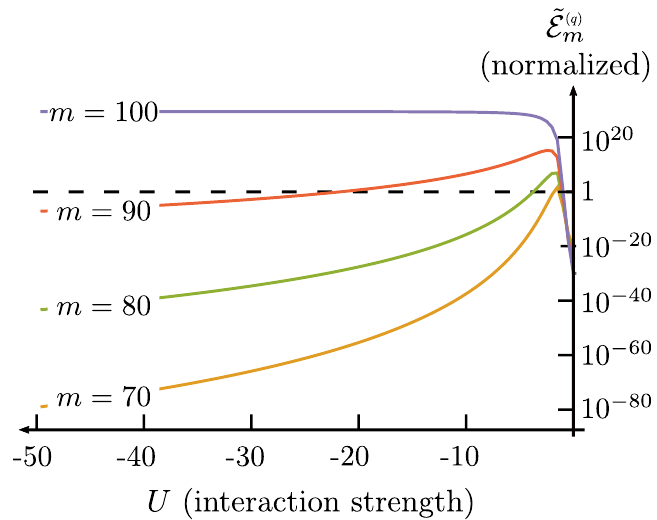
( q ) Figure 3: The Bell correlators ˜ E calculated with the ground state of the Hamilto- m nian (33) with N = 100 qubits, as a function of the interaction strength U ∈ [ − 50,0 ] ,